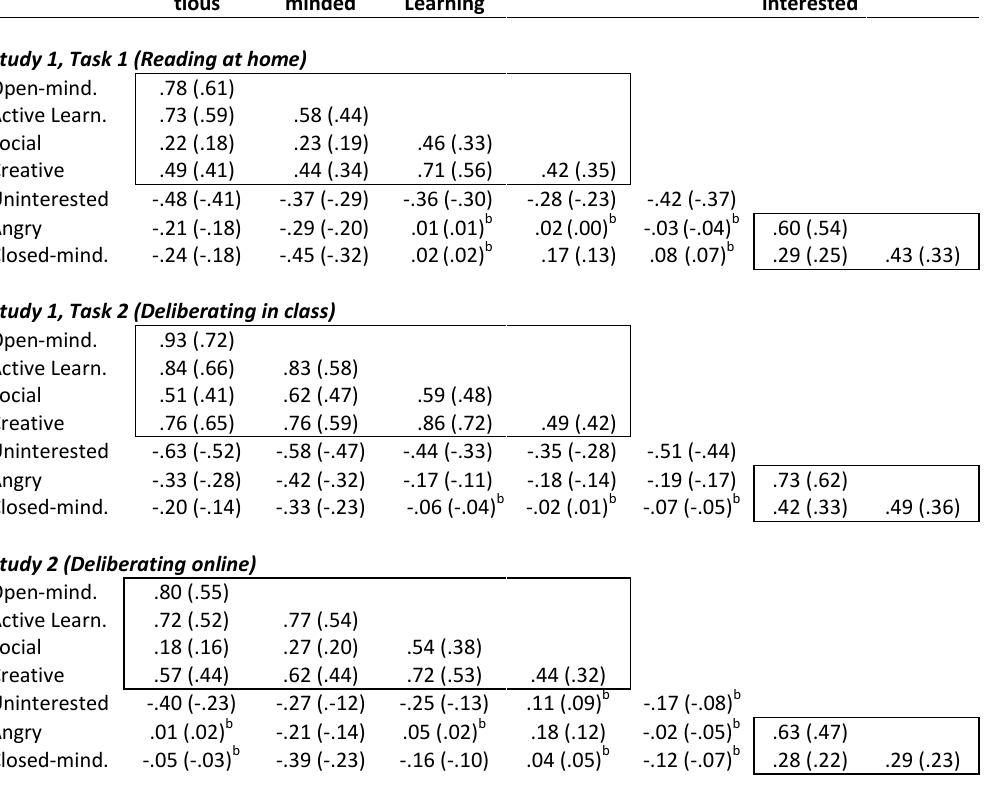
Table 3. Correlations between CFA Factors (Correlations between Mean Scale Scores)